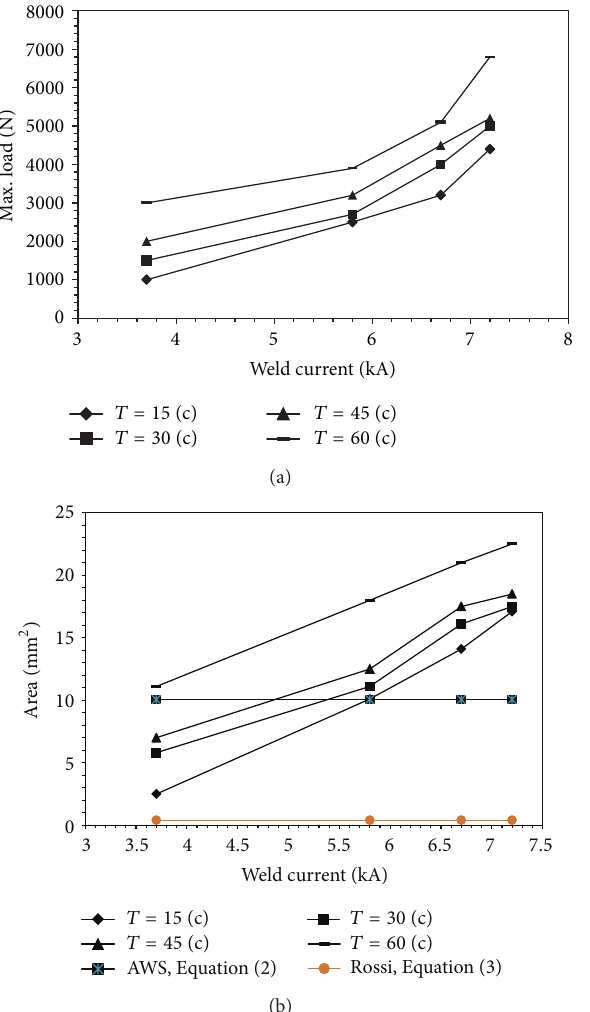
Figure 2: Effect of current of the lap joints, 𝑑 (a) tensile strength; (b) weld nugget area.